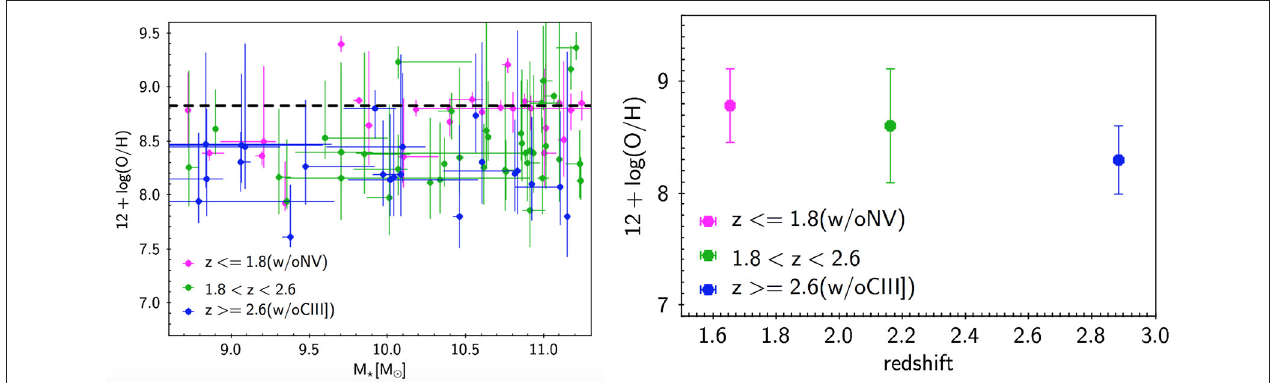
FIGURE 2 | Left: AGN NLR gas metallicity, in terms of Oxygen abundance 12 + log(O/H), for the C IV λ 1550-selected Type 2 AGN described in section 4.1 vs. stellar masses of the host galaxies The measurements are color coded for different redshift bins as shown in the legend. The black dashed line indicates the value of the solar metallicity, Z ⊙ = 0.01524, used in the models described in section 2. Right: Oxygen abundance, 12 + log(O/H), of the AGN NLR averaged for three redshift bins as labeled in the